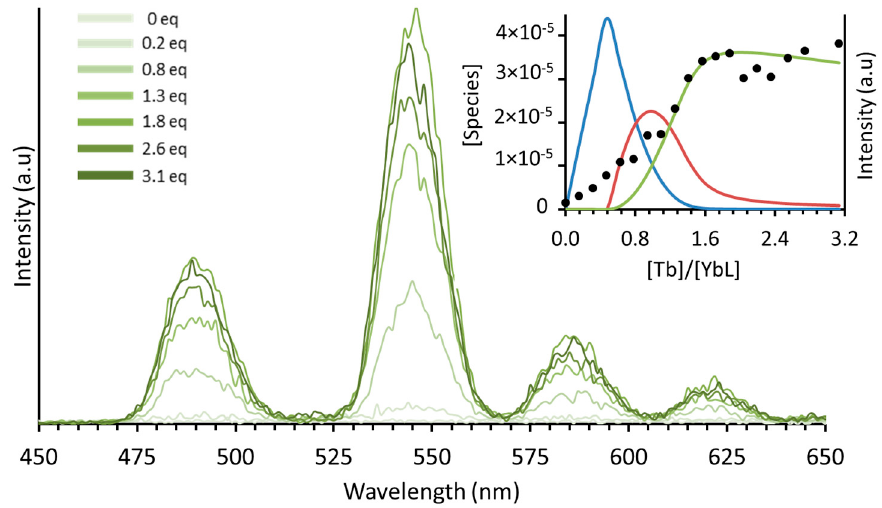
Figure 3. Evolution of the visible terbium emission during the titration of YbL by TbCl 3 · 6H 2 O ( λ ex = 980 nm; YbL = 9.7 × 10 − 5 M; Tb = 7.7 × 10 − 4 M; solutions in D 2 O, pD = 7.7). The inset shows the evolution of the UC intensity (black dots) and evolution of the concentrations of the species formed during the titration ([(YbL) 2 Tb], blue; [(YbL) 2 Tb 2 ], red and [(YbL) 2 Tb 3 ] in green).